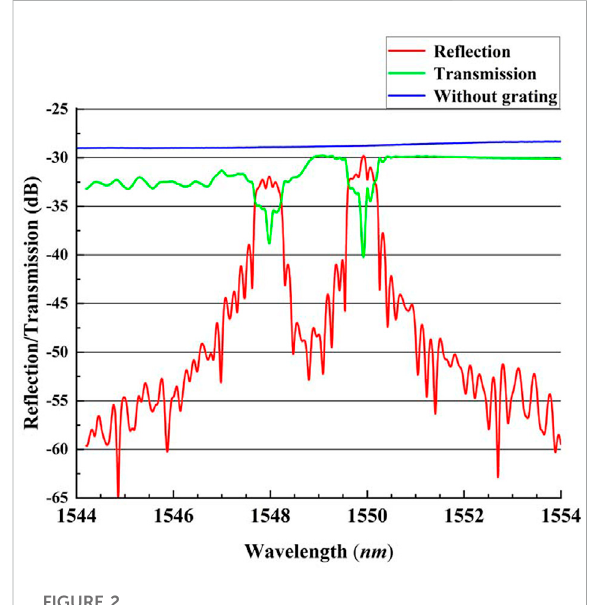
FIGURE 2 The spectra of 2D FBG at room